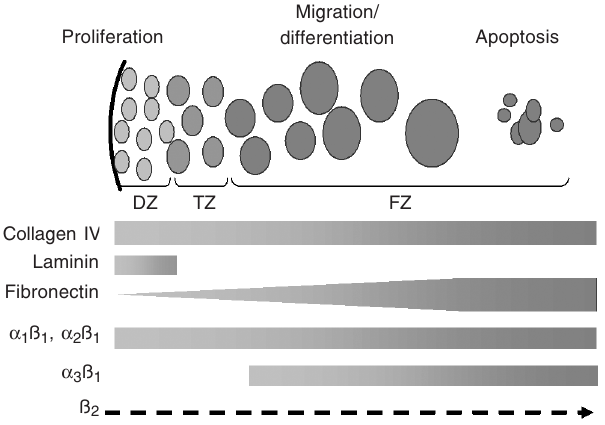
Figure 2. Schematic representation of extracellular matrix components ex- pressed in the human fetal adrenal gland. Cells of the fetal adrenal cortex proliferate in the definitive zone (DZ, light grey), then enter the transitional zone (TZ, medium grey) where they begin their migration throughout the whole fetal cortex, differentiate progressively into fetal zone cells (FZ, dark grey) and finally die from apoptosis in the center of the fetal zone. Collagen IV is expressed throughout the fetal cortex, as also are integrins α 1 , α 2 and ß 1 chains. Laminin expression is restricted to the definitive zone, whereas fibronectin exhibits a gradient of expression more concentrated in the center of the gland. The integrin α 3 is expressed only in the fetal zone, and a strong expression of the ß 2 chain has been described on the surface of chromaffin